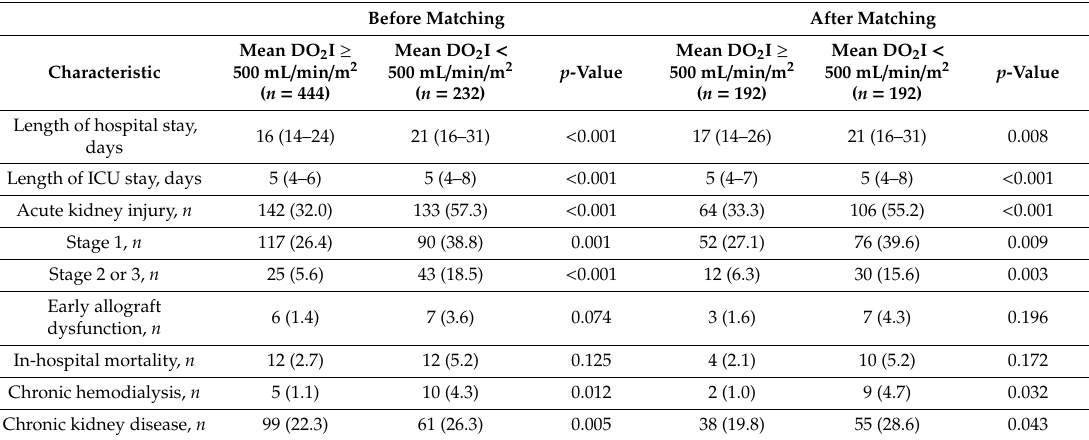
Table 3. Comparison of postoperative clinical outcomes between the patients with high and low mean intraoperative oxygen delivery index (mean DO 2 I). Before